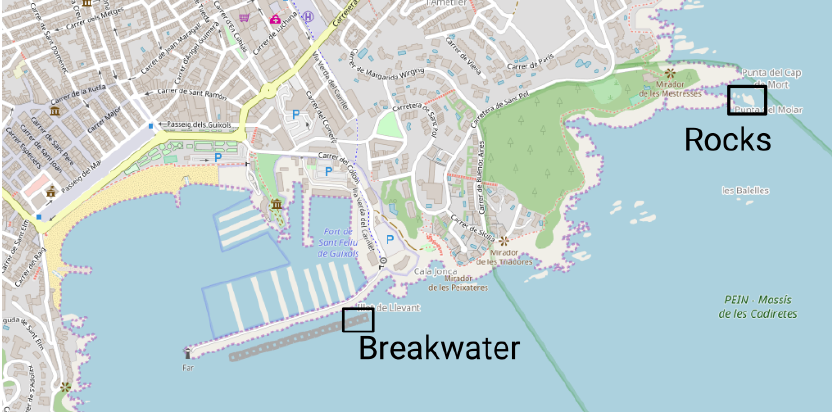
Figure 8. Location of both real-world datasets along Sant Feliu de Guixols’ coast (source: OpenStreetMap c (cid:13) ).